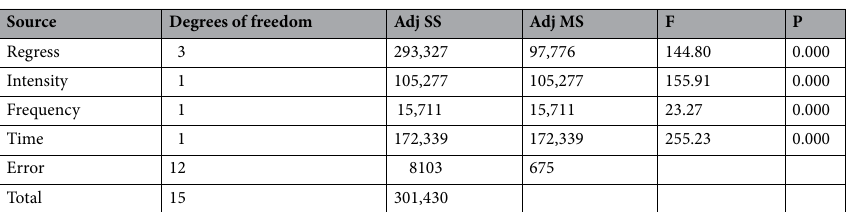
Table 5. Analysis of variance of the roof deformation regression model. Adj SS is the adjusted sum of squares; Adj MS is the squared sum of deviations; F is the test value; P is the significant difference